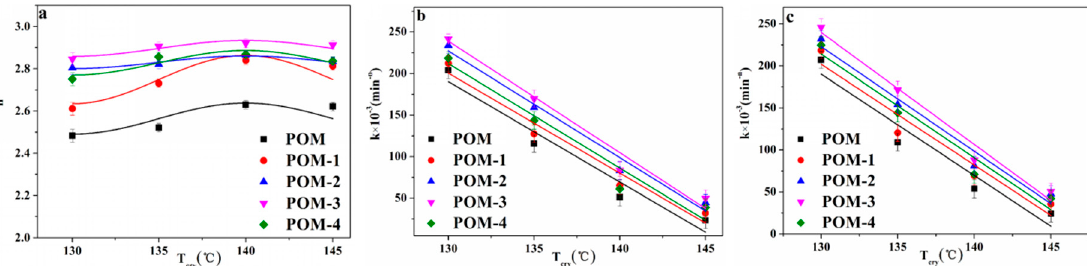
Avrami rate constant ( k ) of POM/Ag nanocomposites.